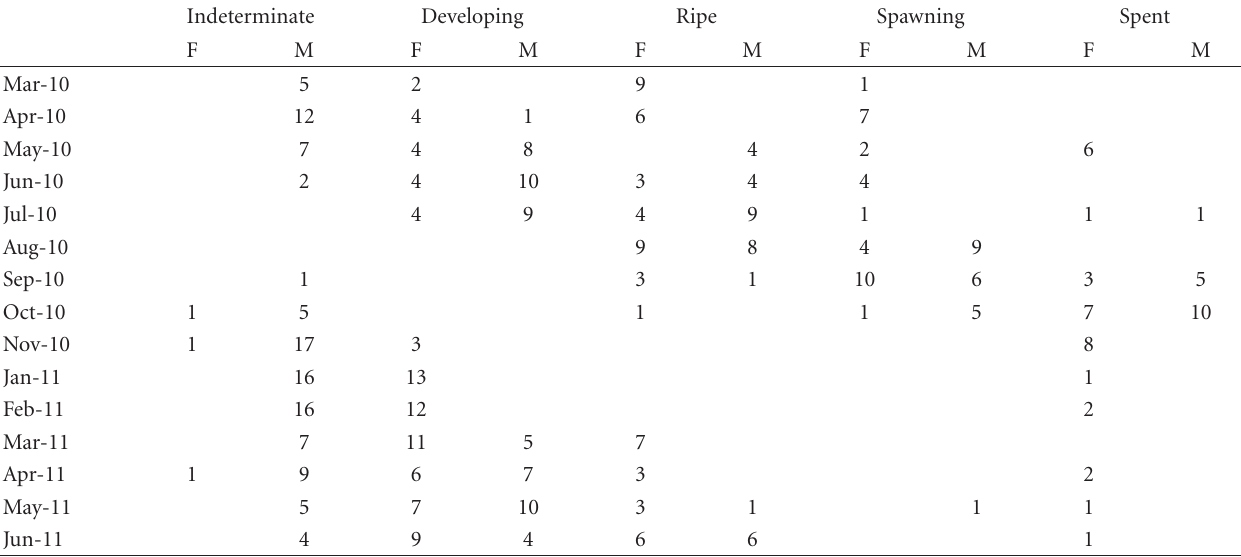
Table 3: The number of female and male Mya arenaria individuals present each month, in the five stages of gametogenesis. Indeterminate Developing Ripe